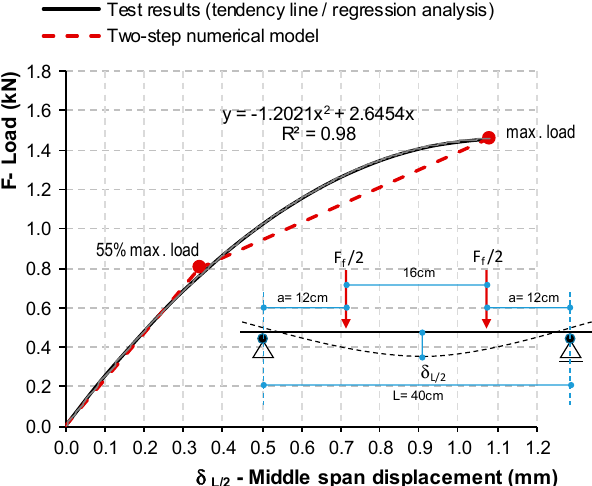
Figure 11. Validation/calibration of the numerical model (simulation vs. test data).